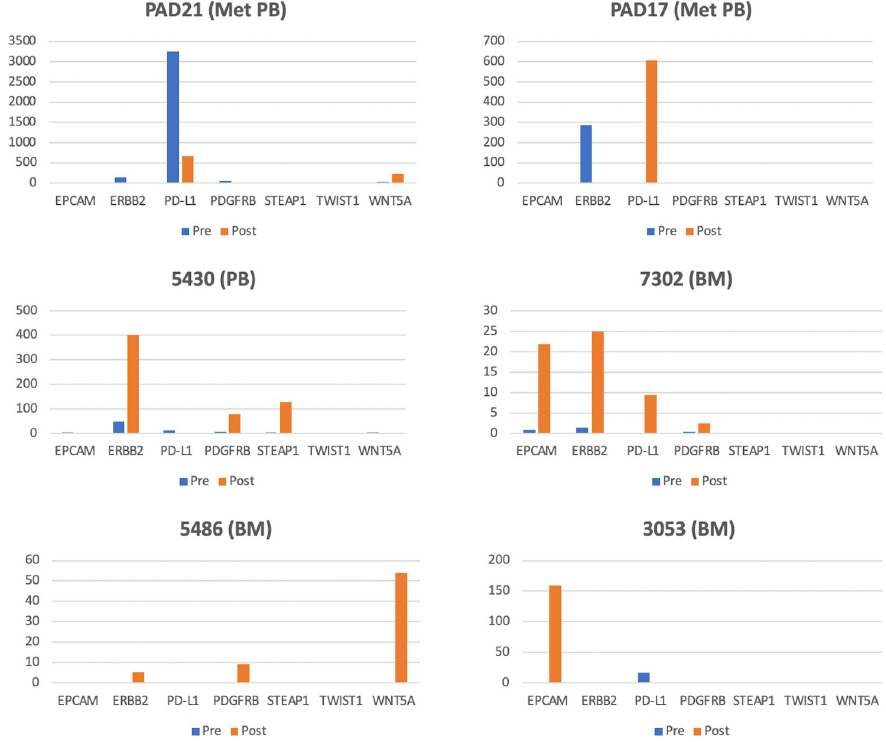
Fig 5. Gene expression of a 7-transcript panel in six different Bone Marrow (BM) and Peripheral Blood (PB) samples from metastatic (Met) and non-metastatic breast cancer patients. Individual gene expression values from cell samples pre- (blue) and post- (orange) Parsortix filtration are expressed as positive droplets per 100,000 GAPDH positive droplets.